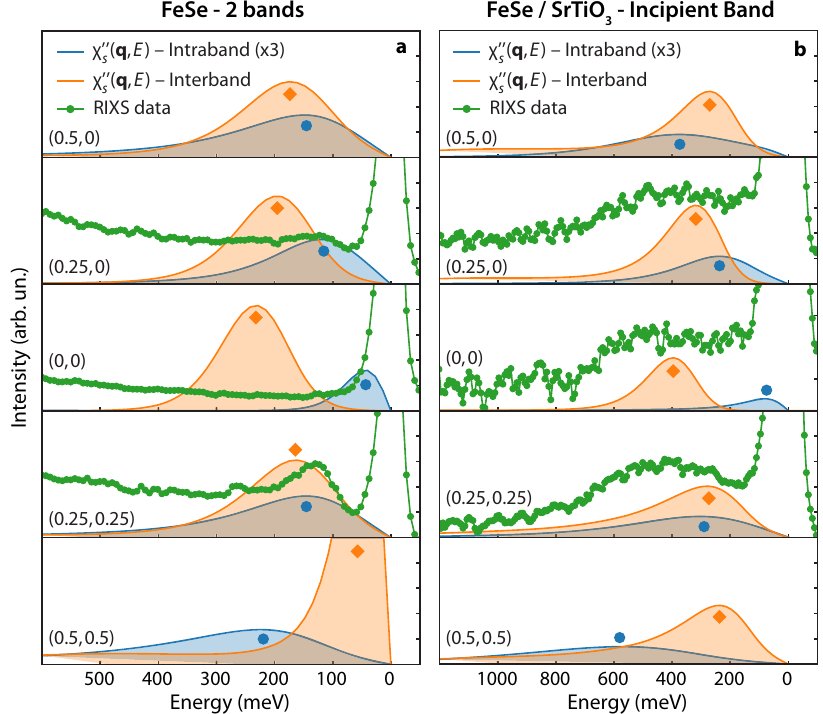
Fig. 4 Comparison of spin susceptibility and Resonant Inelastic X-Ray Scattering (RIXS) data. a Dynamical Cluster Approximation (DCA) calculations of the imaginary part of the spin susceptibility χ 00 s ð q ; ω Þ for the incipient band Hubbard model (blue lines: intraband k z = 0; orange lines: interband k z = π ) and b the two-band Hubbard model (blue lines: intraband k z = 0; orange lines: interband k z = π ). Orange (blue) circles indicate the energy position of the maximum of the spin susceptibility in the interband (intraband)